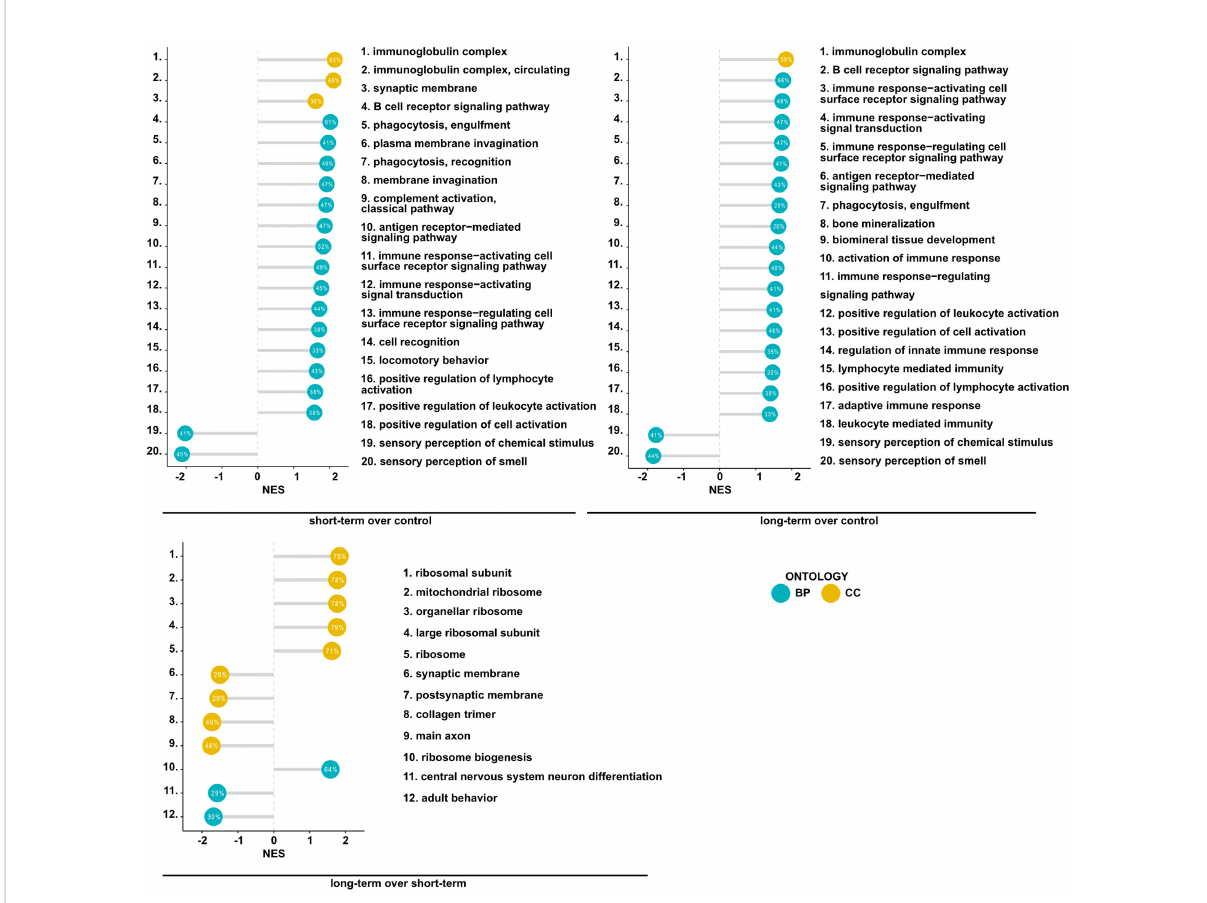
FIGURE 2 Mesenchymal stem cell administration to non-in fl amed lungs induces the expression of genes associated with immunological pathways. Summary of gene set enrichment analysis for gene ontology. Top 20 most signi fi cant GO terms are listed according to the adjusted p-value. Ontologies are presented using lollipop charts with normalized enrichment scores. The percentage values represent the coverage of DEGs in each group to the theoretical size of an analyzed term. Blue and yellow refer to biological processes (BP) and cellular components (CC) of gene ontology,